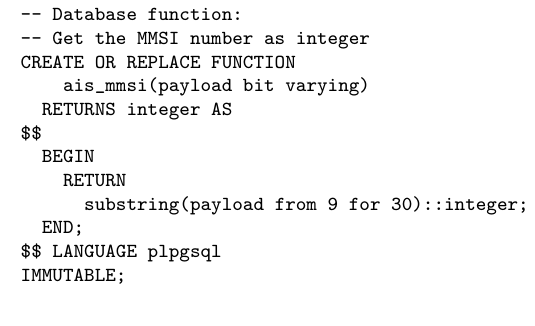
Figure 6. Example of function within PostgreSQL database to decode MMSI number from bit vector data